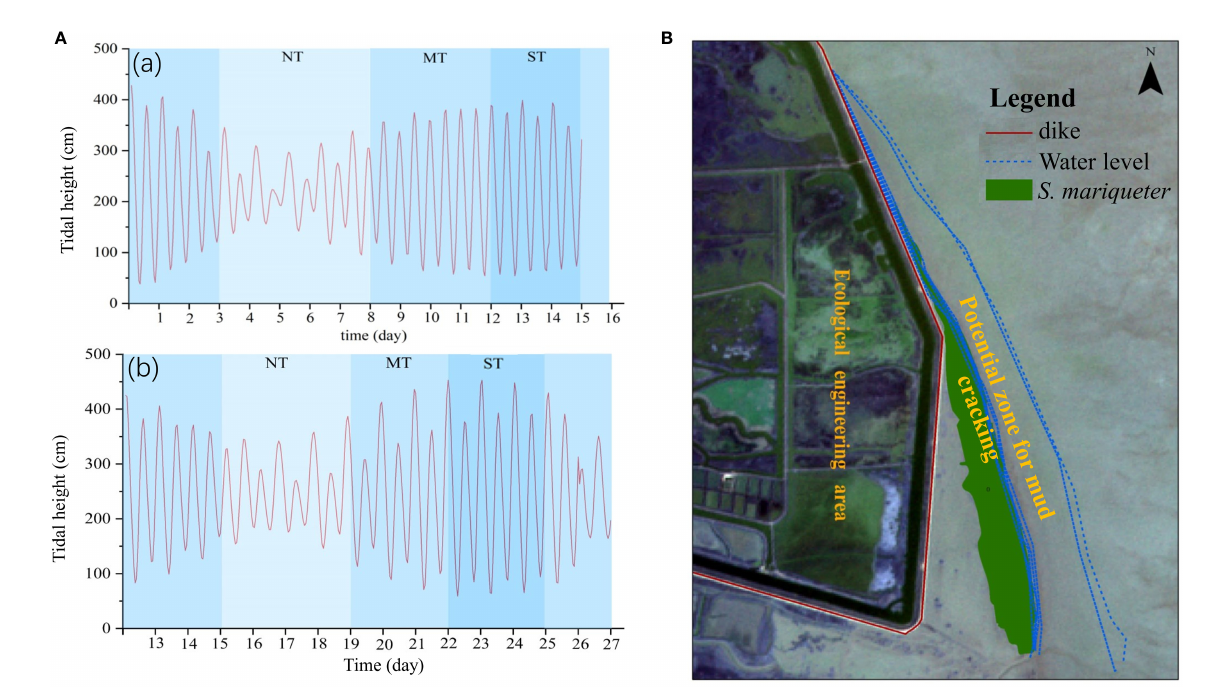
FIGURE 3 Tidal heights and tidal regimes in the Chongming Dongtan wetland. (A) Variations in tidal heights in April 2021 (a) and August 2021 (b); NT, MT, and ST are neap tide, middle tide, and spring tide, respectively. (B) Variations in tidal regimes from January to August 2021. The zone between water levels is de fi ned as the potential mud cracking zone and a potential ecological restoration zone for plant dispersal and